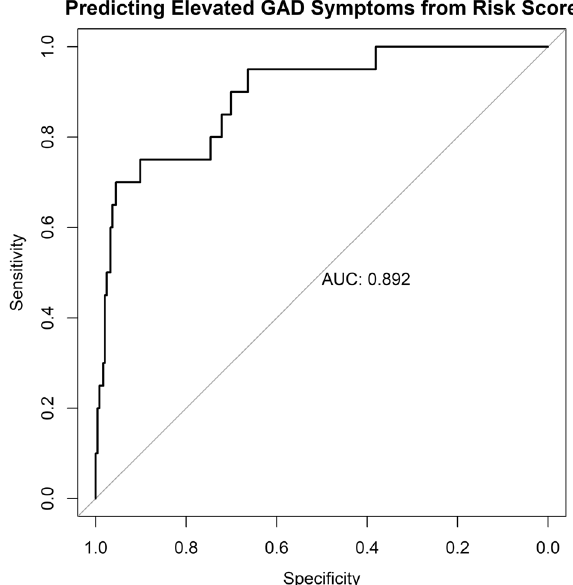
Fig. 2 The current plot depicts the receiver operating character- istic curve. The black line describes the differentiating sensitivity and speci fi city of the risk of elevated symptoms (de fi ned as greater than 1 standard deviation above the population mean in GAD symptoms) across varying levels of the risk scores. Note that the grey line is what would be expected by chance.